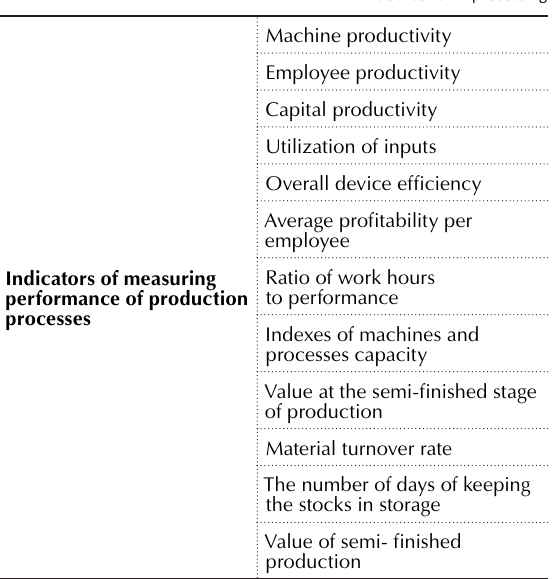
Table 3. Indicators of measuring performance of production processes